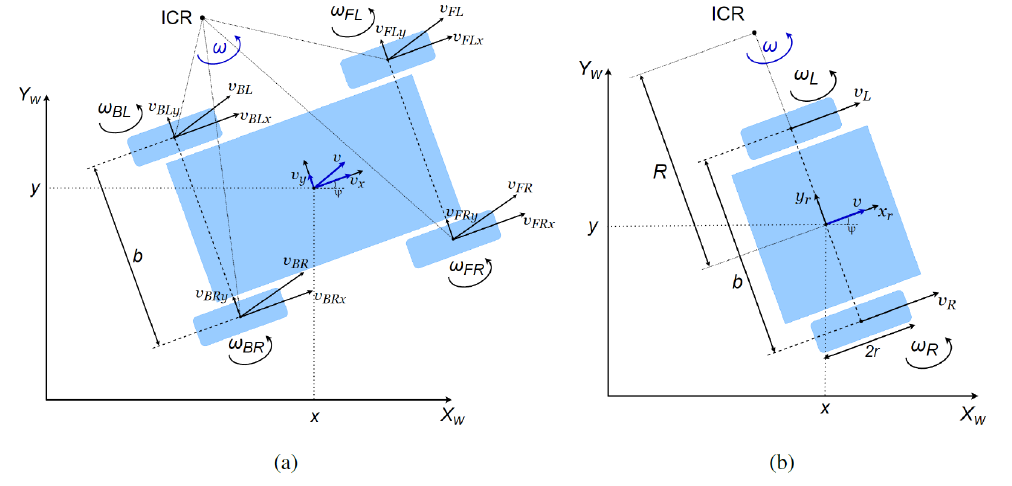
Figure 2. Motion model: ( a ) skid steering, and ( b ) two-wheel differential